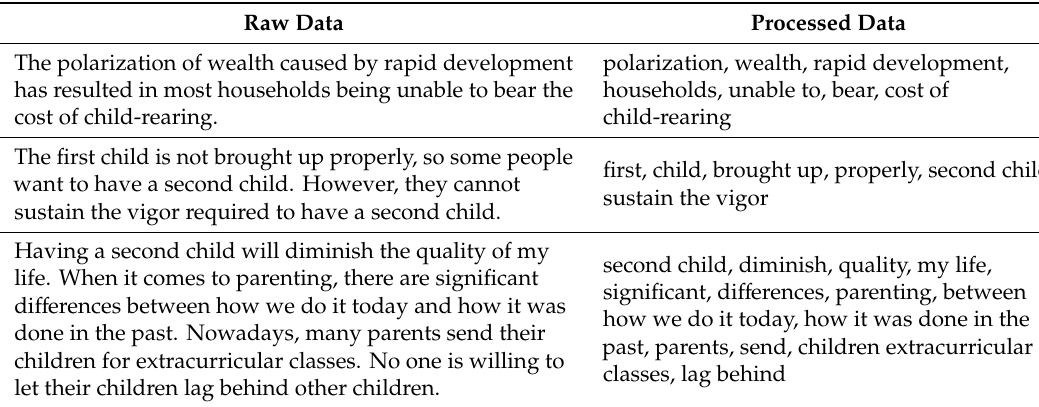
Table 1. The raw and processed